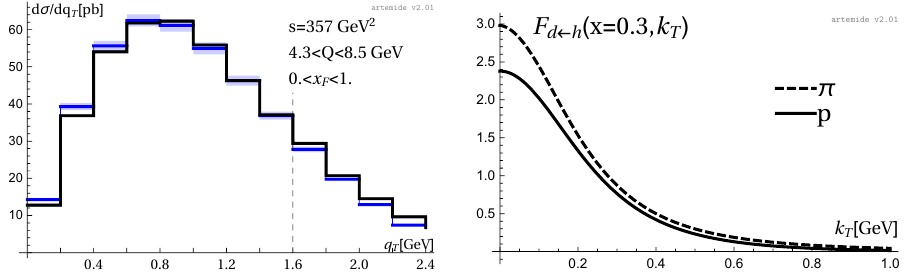
Figure 7 . (Left) Comparison of theory prediction to the preliminary results of COMPASS [52]. The experimental values are normalized to the theory. Vertical line shows approximate boundary of TMD factorization approach. (Right) Comparison of unpolarized TMDPDF of d-quark in pion and proton at x = 0 :